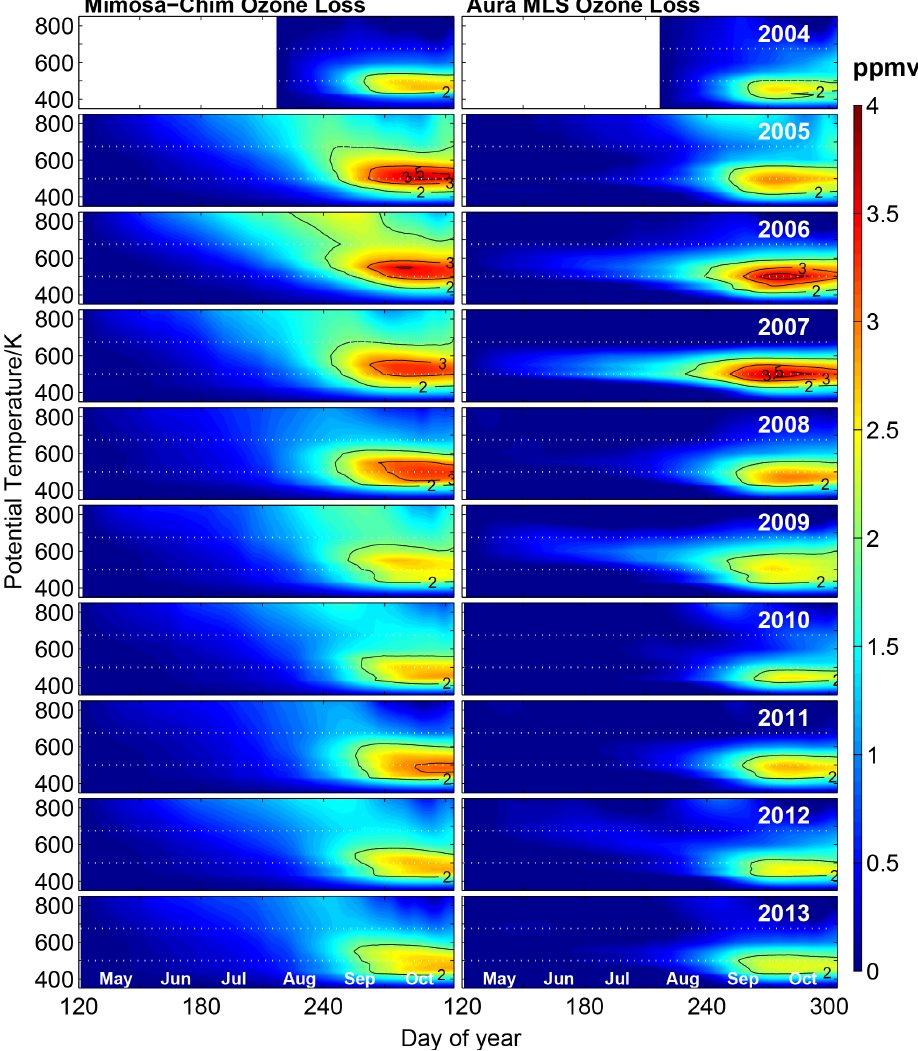
Figure 5. Vertical distribution of the vortex-averaged (defined by ≥ 65 ◦ EqL) ozone loss estimated for the Antarctic winters in 2004–2013. The model results are interpolated with respect to the time and location of the MLS measurements inside the vortex and then averaged for the corresponding day. Left: the ozone loss derived from the difference between the passive ozone and the chemically integrated ozone by MIMOSA–CHIM. Right: the ozone loss derived from the difference between the MIMOSA–CHIM passive ozone and the ozone measured by MLS. Both model results and MLS data are smoothed for 7 days. The y axis represents potential temperature in K. The white dotted lines represent 500K ( ∼ 19km) and 675K ( ∼